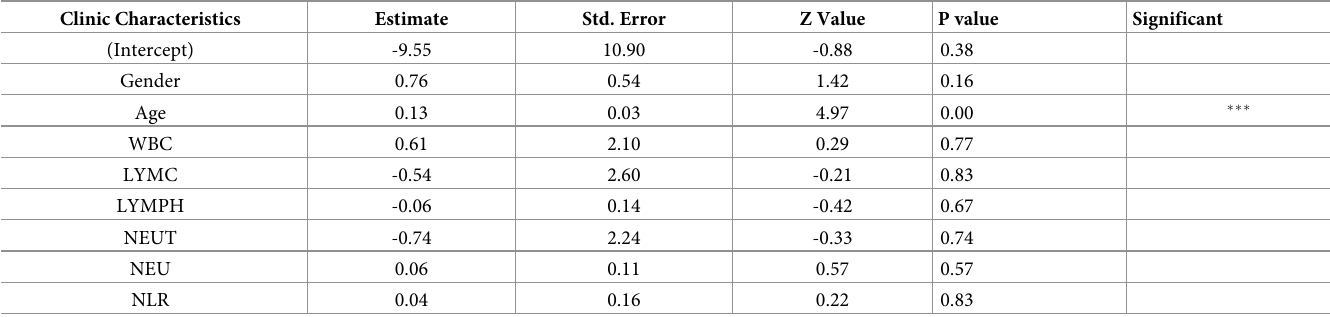
Table 2. The joint significance of clinical characteristics.